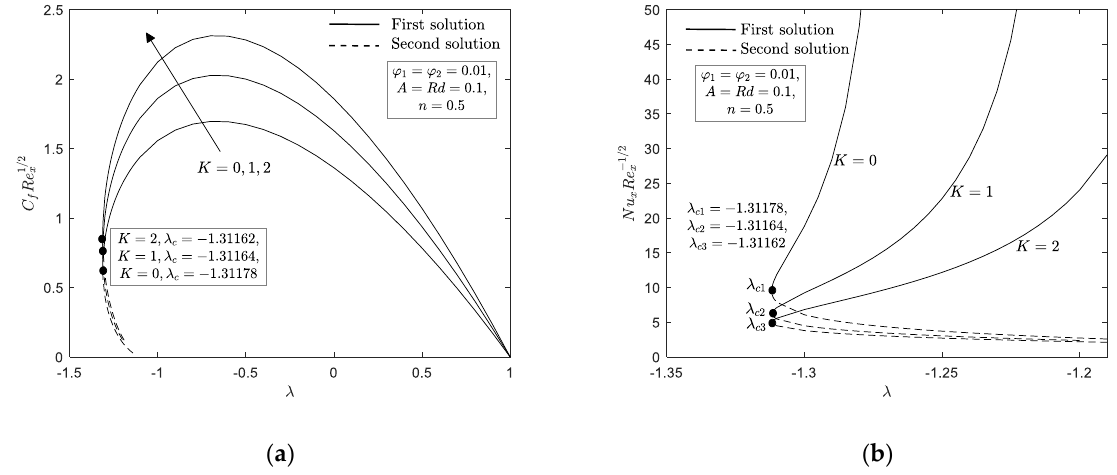
− 1/2 with  for various K Figure 6. ( a ) C f Re x with λ for various K